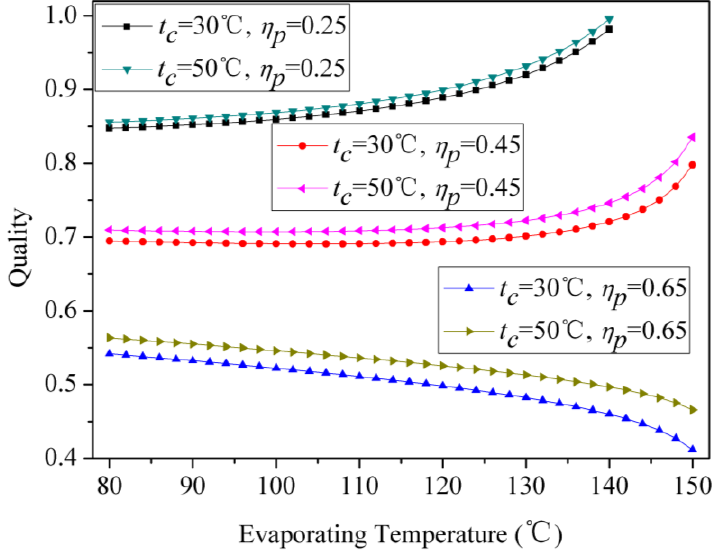
Figure 6. The minimum vapor quality required vs. evaporating temperature (R245fa).